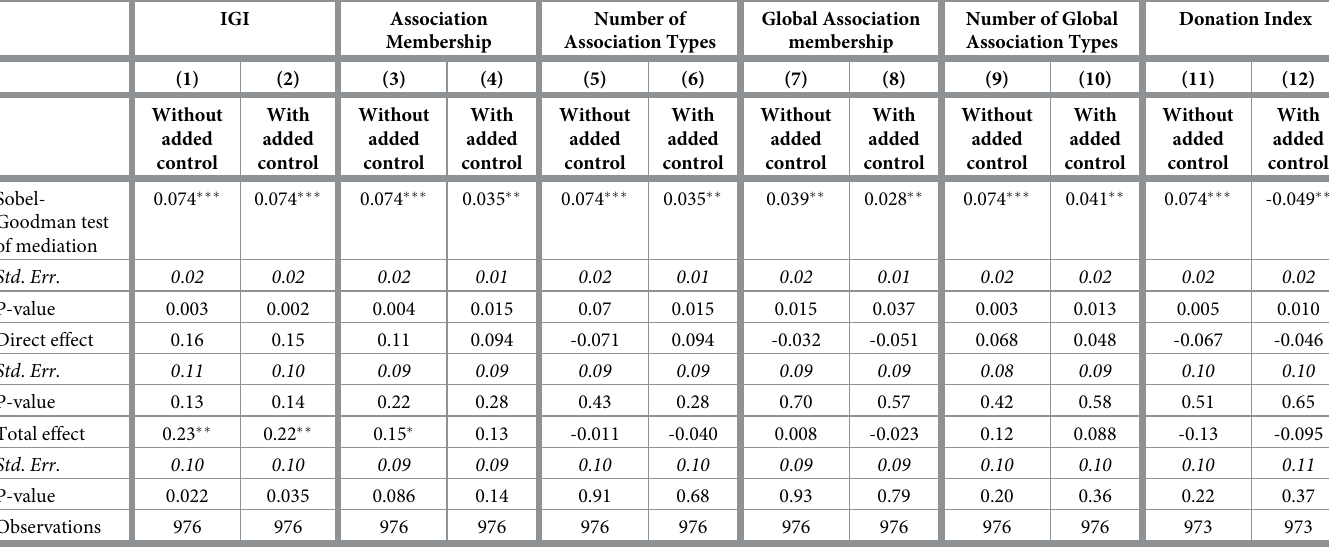
Table 3. Robustness analysis of mediation, direct and total effects for alternative independent variables.